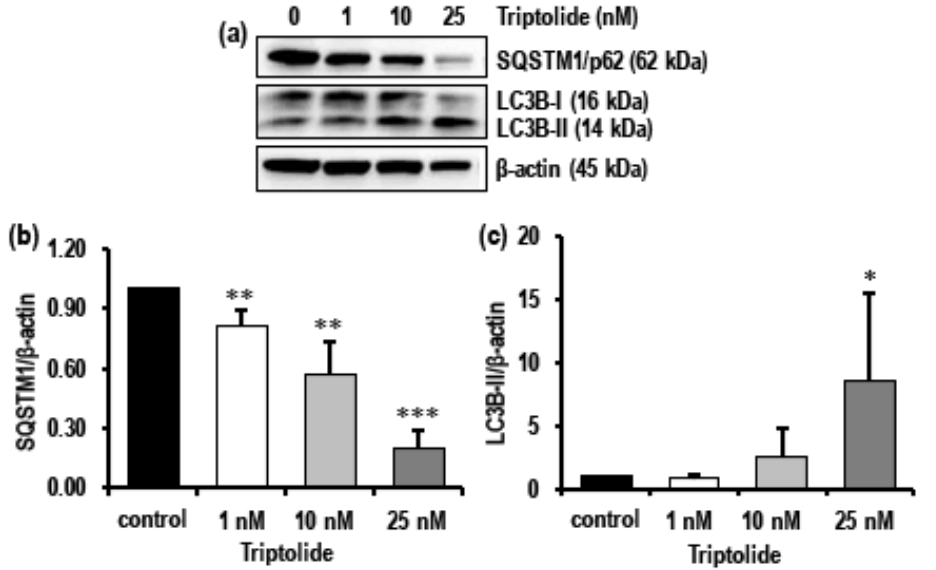
Figure 5. Effect of triptolide on the levels of SQSTM1/p62 and LC3B (autophagy related protein) in MDA-MB-231 cells after 72 h of triptolide treatment. ( a ) Representative Western blots show the levels of SQSTM1/p62 and LC3B in MDA-MB-231 cells treated with varied concentrations (1 nM, 10 nM, and 25 nM) of triptolide for 72 h. ( b ) Activation of autophagy was indicated by concentration-dependent decrease in level of SQSTM1/p62 and ( c ) an increase in the level of LC3B II. β -Actin was used as loading control. Values are expressed as mean ± SD from four to five experiments. Density was normalized to β -actin and ratio was calculated against untreated control. *, p -value < 0.05; **, p value < 0.001; ***, p value < 0.0001.